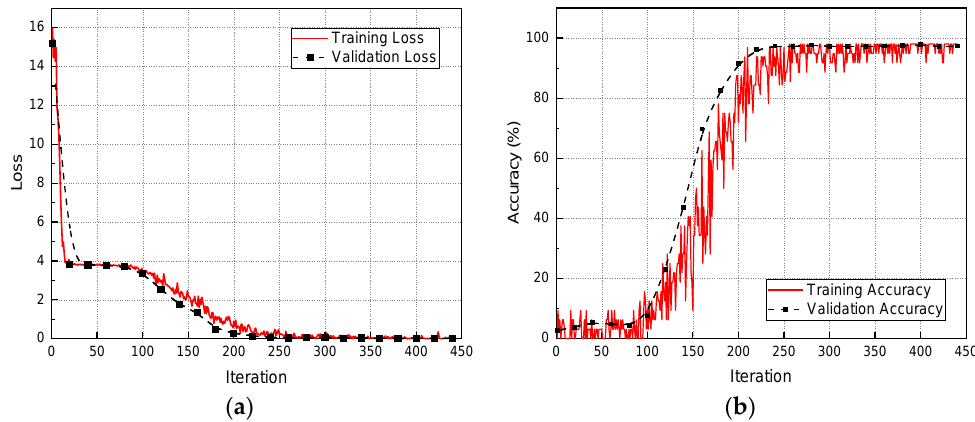
Figure 8. ( a ) Model training loss and validation loss; ( b ) model training accuracy and validation accuracy.